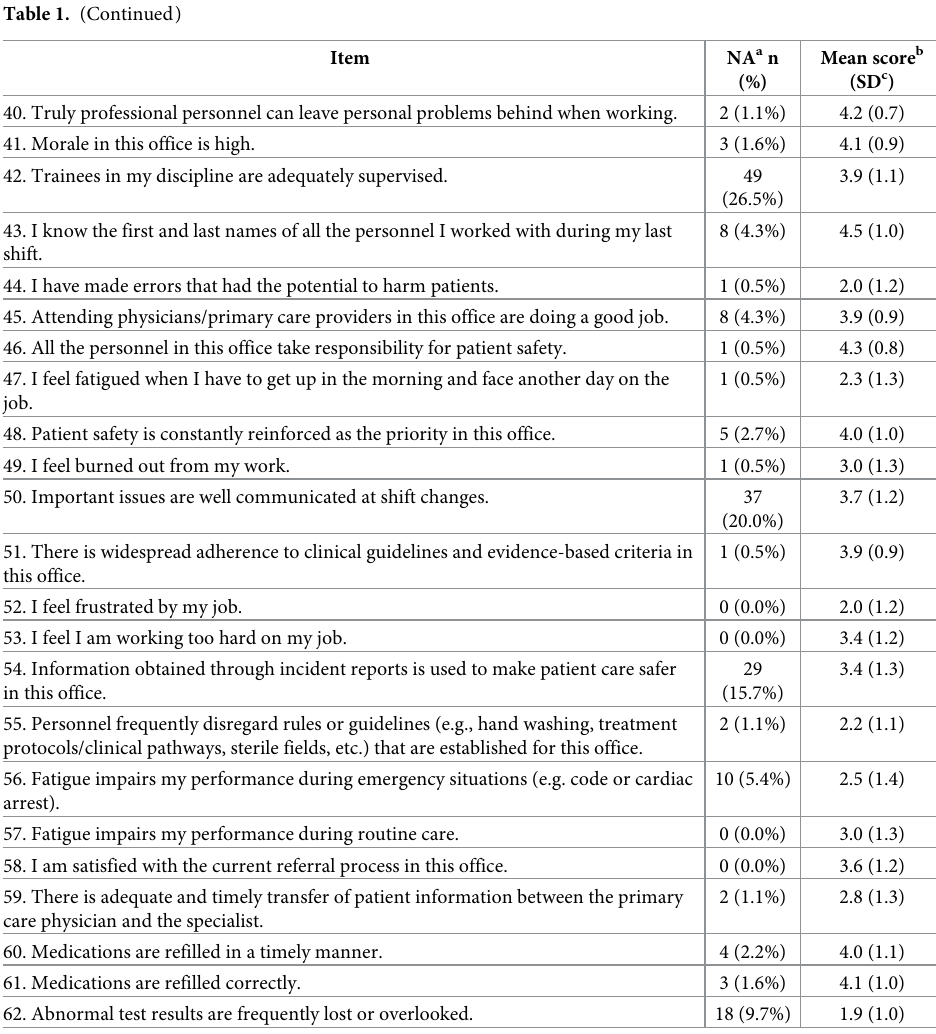
ranged between 0.53 and 0.81 for the first factor, between 0.56 and 0.69 for the second factor, between 0.62 and 0.77 for the third factor, between 0.56 and 0.88 for the fourth factor, and between 0.52 and 0.74 for the fifth factor. Croatian translation of items is provided in (S1